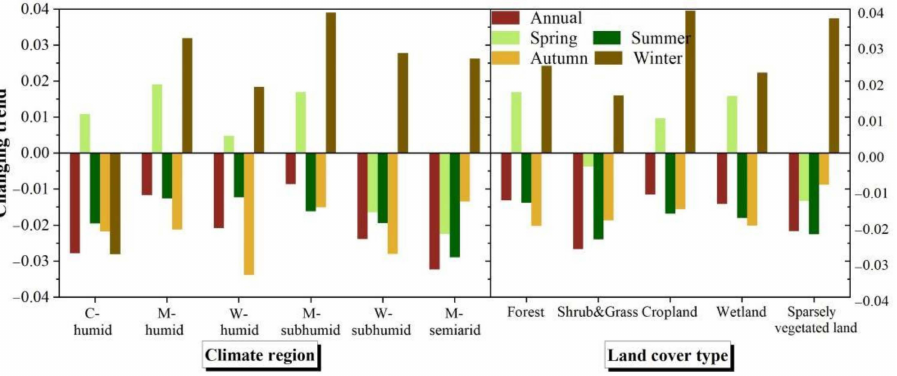
Figure 11. Average annual and quarterly changing trend over different climate regions and land cover types in northeast China (NEC) from 1990 to